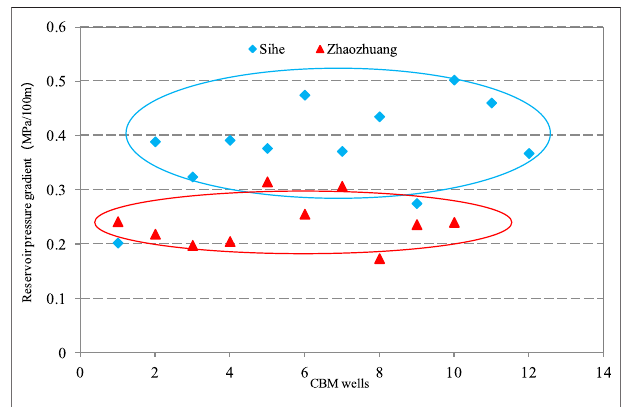
FIGURE 11 | Distribution of reservoir pressure gradient in No. 3 coal